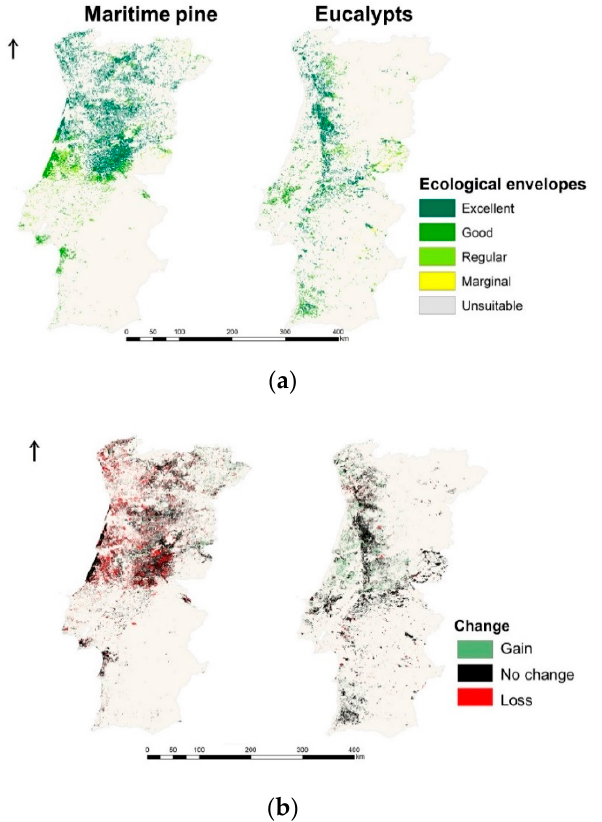
Figure 6. ( a ) Species distributions in 1995 (COS1995) by ecological envelope class; ( b ) Species forest cover change (COS1995-COS2015).